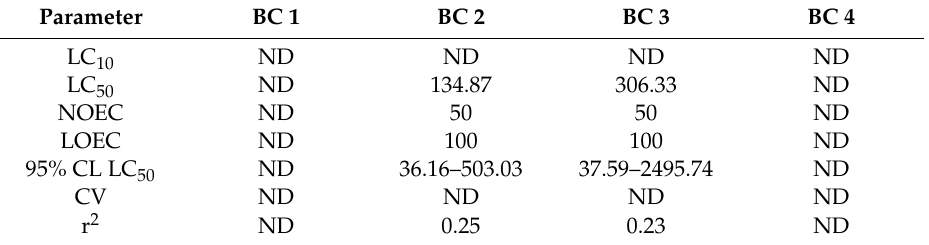
Figure 5. Photograph of dead Moina Macrocopa . Digestive tract fully filled with BC particles as indicated by the arrows. Table 8. Acute toxicity values of Moina Macrocopa to BCs 5 .